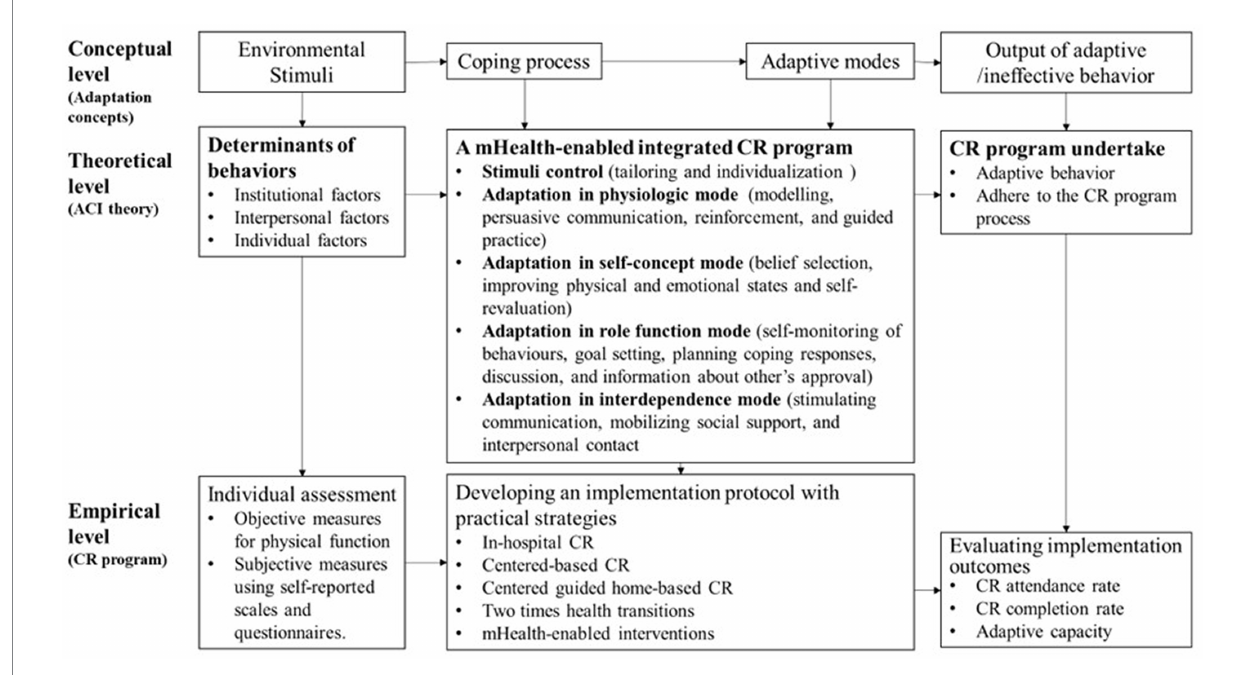
FIGURE 4 Conceptual-theoretical-empirical framework for this integrated CR program based on the ACI